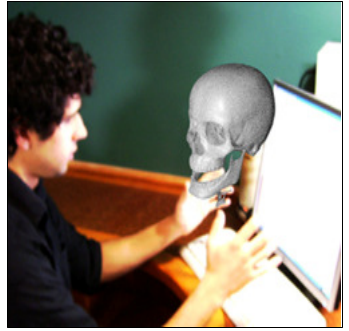
Figure 5. Natural interface in the VIDA Project